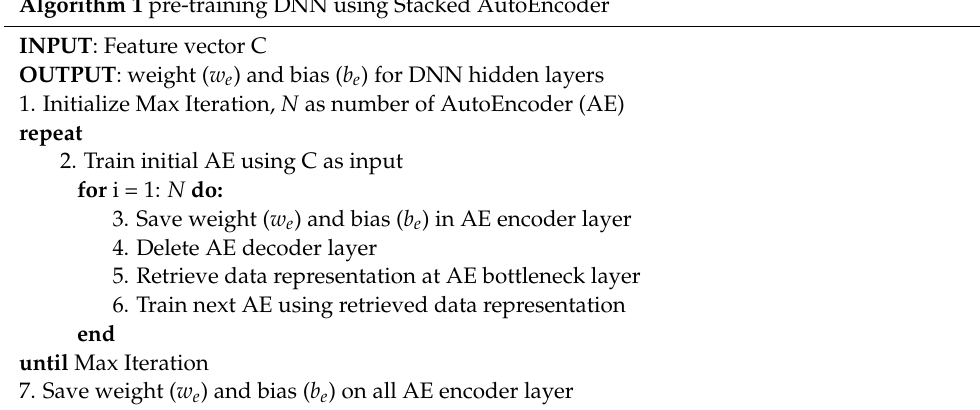
Algorithm 1 pre-training DNN using Stacked